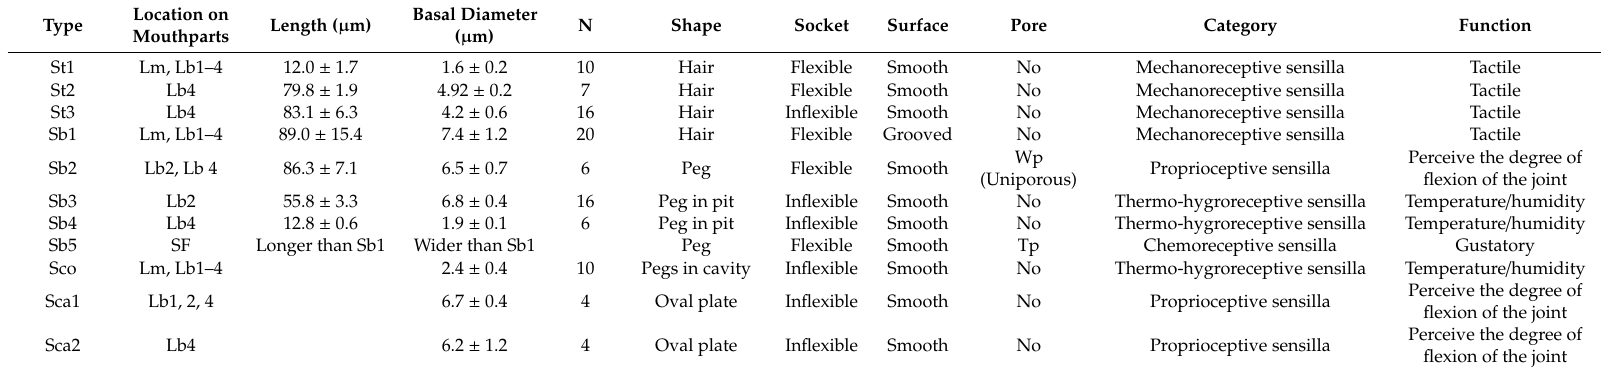
Table 2. Distribution, morphometric data (mean ± SE), terminology and definition of sensilla used in the present paper. Data are mean ± SE values obtained from scanning electron microscopy. N = sample number; Lm, labrum; Lb, 1, 2, 3, 4, the first, second, third, fourth segment of labium; St 1–3, sensilla trichodea 1–3; Sb 1–5, sensilla basiconica 1–5; Sco, sensilla coeloconica; Sca 1–2, sensilla campaniformia 1–2; SF, sensory field on the labial tip; Wp, wall pore; Tp, tip